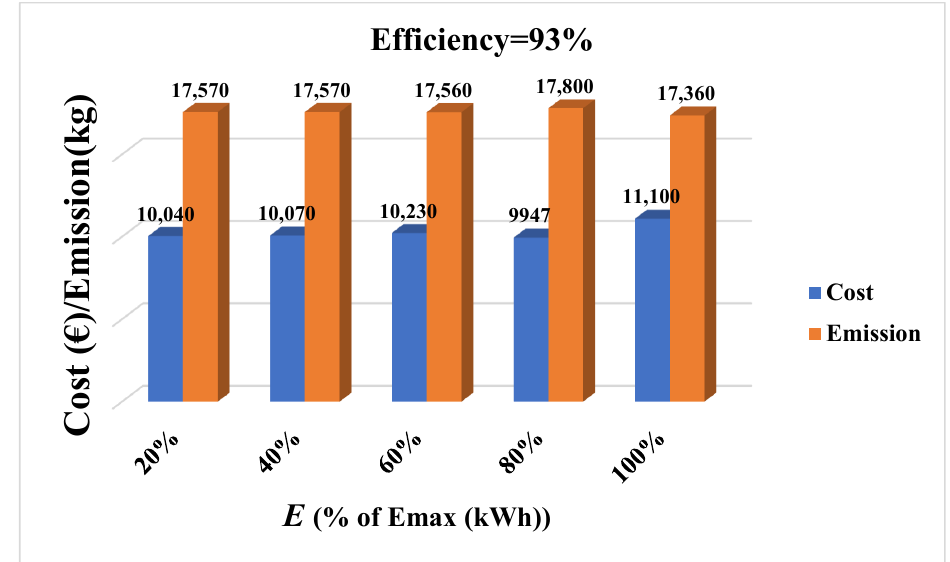
Figure 6. Estimated values of ( a ) load demand and ( b ) utility hourly prices [40].